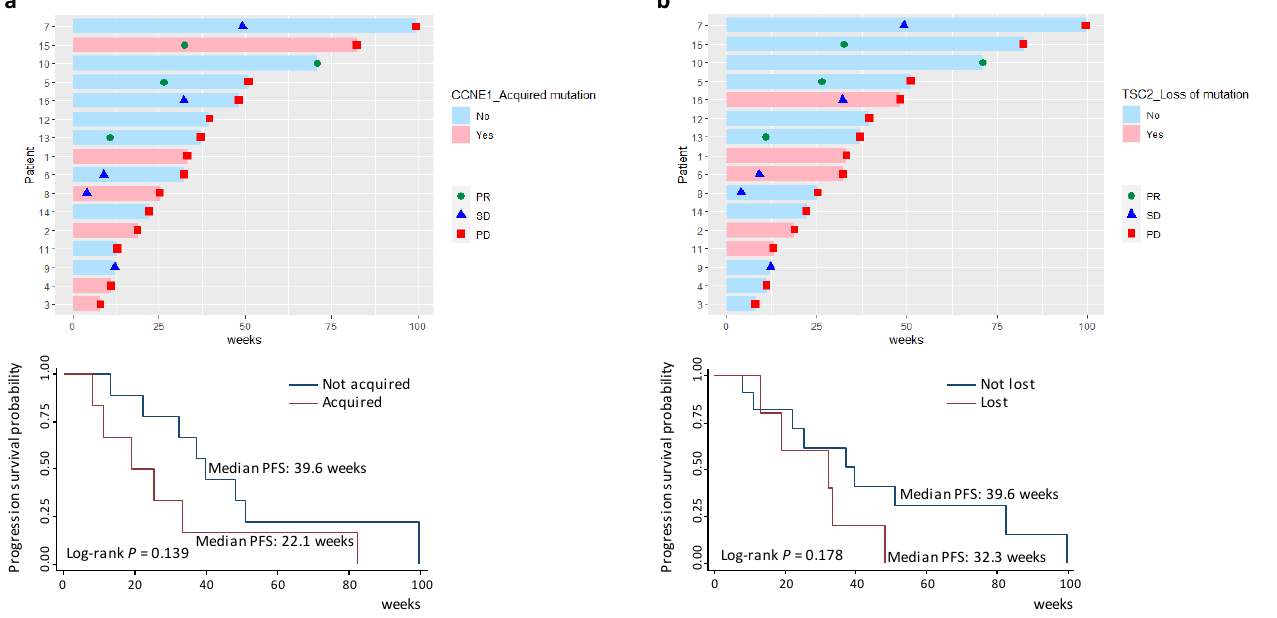
Figure 5. RECIST responses during follow-up for individual patients and survival difference between patients who acquired or did not acquire CCNE1 mutations ( a ) and between patients who lost or did not lose TSC2 mutations ( b ). RECIST: the Response Evaluation Criteria in Solid Tumors; PD: progressive disease; PR: partial response; SD: stable disease.